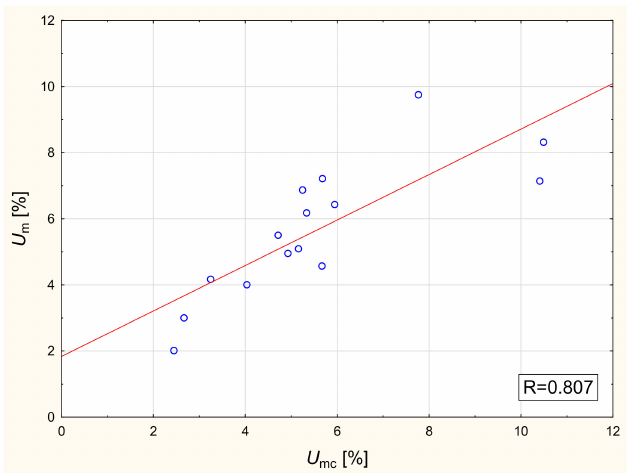
Figure 6. Relationship between U m mass humidity obtained on the basis of gravimetric tests and U mc humidity identified by the neural network for experimental verification.